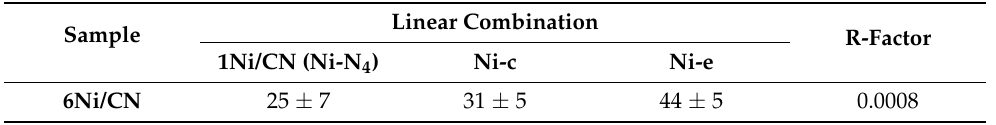
Table 3. The content of different Ni coordination centers in 6Ni/CN obtained by the linear combination fitting of the Ni K-edge XANES spectrum.